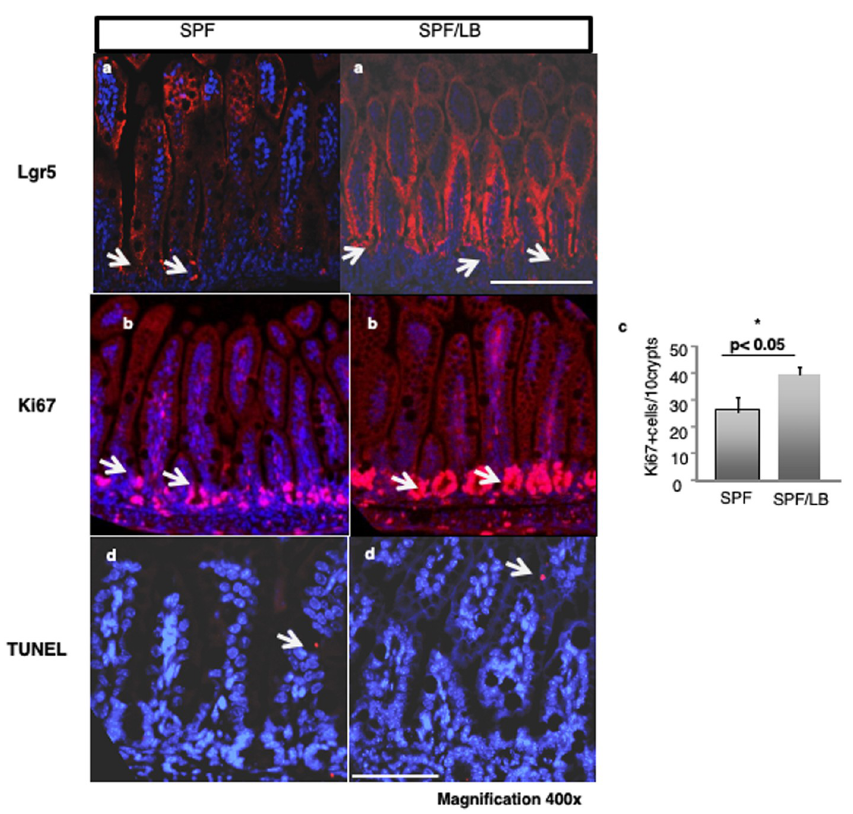
Fig 2. Maternal LB modulates intestinal epithelial cell proliferation in preweaned mouse pups. a) Immunofluorescence detection of LGR5 positive cells (red) in mouse ileal crypts of SPF and SPF/LB. Representative areas (n = 4 per group) are shown. Bar: magnification 400x; white arrows indicate positive staining in the crypts. b) Immunofluorescence detection of Ki-67 positive cells (red) in the crypts. Representative areas (n = 4 per group) are shown. Bar: 100 μ M. magnification 400x. c) Quantification of Ki-67 positive cells (mean ± SEM) and student’s t-test � p < 0.05. d) TUNEL staining for apoptosis was analyzed in mouse ileal tissue sections with or without LB (In situ Cell Death Detection Kit, Fluorescein; Roche Diagnostics). Representative areas (n = 3 per group) are shown. Bar: magnification 400x. molecules (Fig 3d, block arrows) in ileal mucosa. Maternal LB exposure partially protected tight junction integrity as shown by the increased preservation of cell surface ZO-1 expression indicated by the thin white arrow in Fig 3e.